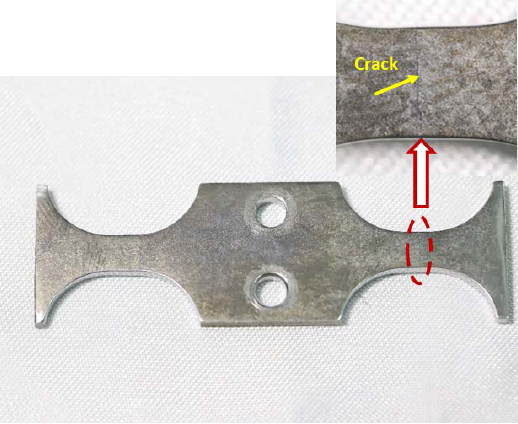
Figure 9. Typical surface crack morphology of specimen failure.